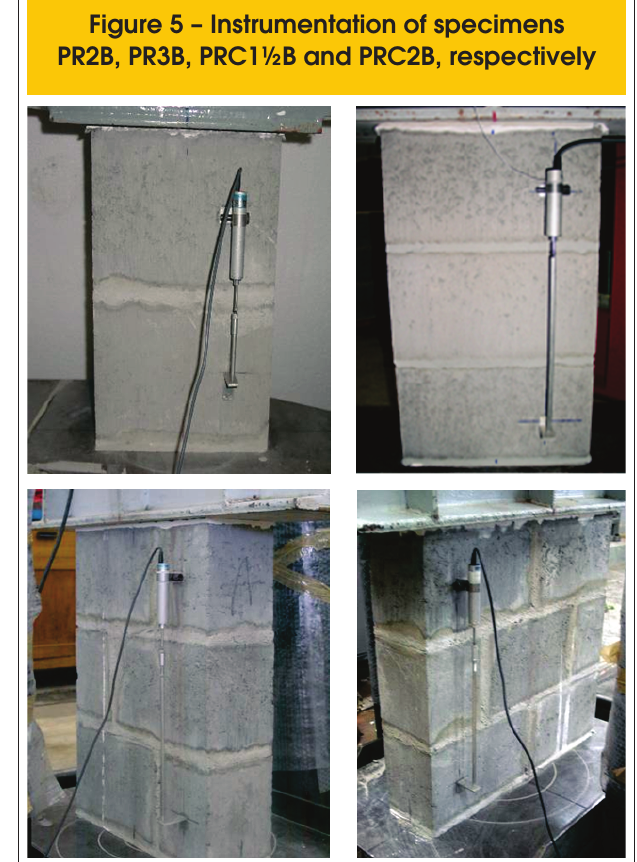
Figure 5 – Instrumentation of specimens PR2B, PR3B, PRC1½B and PRC2B,